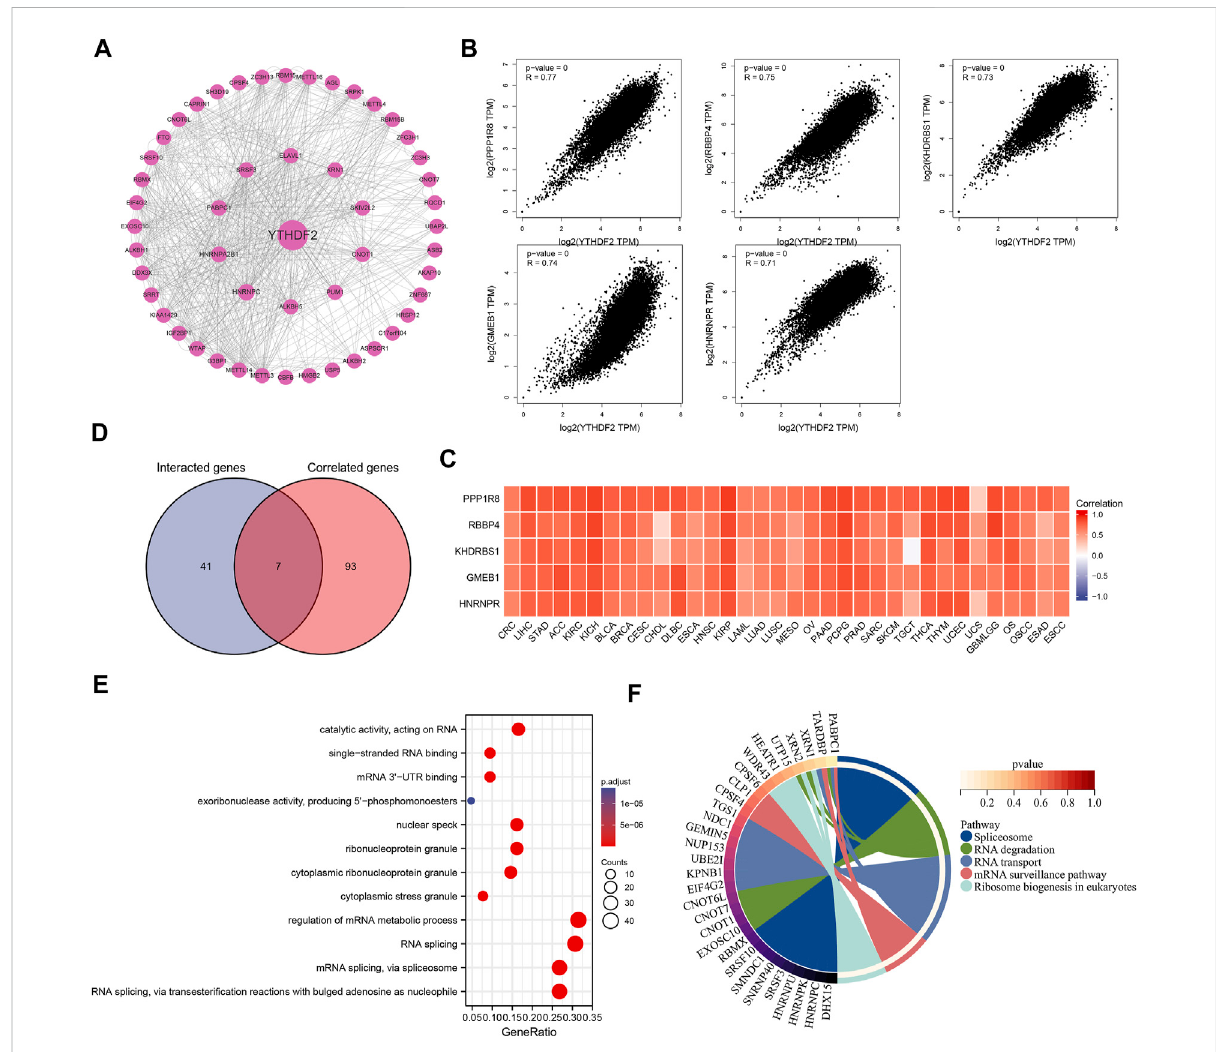
FIGURE 9 The protein-protein interactions network, Go enrichment analysis and KEGG pathway analysis. (A) The YTHDF2 interacting proteins that screened by the online STRING tools. (B) The top 100 YTHDF2-related genes in TCGA database, among which the top fi ve targeting genes are screened out. (C) The heatmap showed the expression of the top fi ve YTHDF2 targeting genes in different cancer types. (D) The cross analysis of YTHDF2-interacting and YTHDF2-related genes. (E) GO enrichment analysis based on the YTHDF2-interacting and YTHDF2-related genes. (F) The KEGG pathway analysis based on YTHDF2-interacting and YTHDF2-related